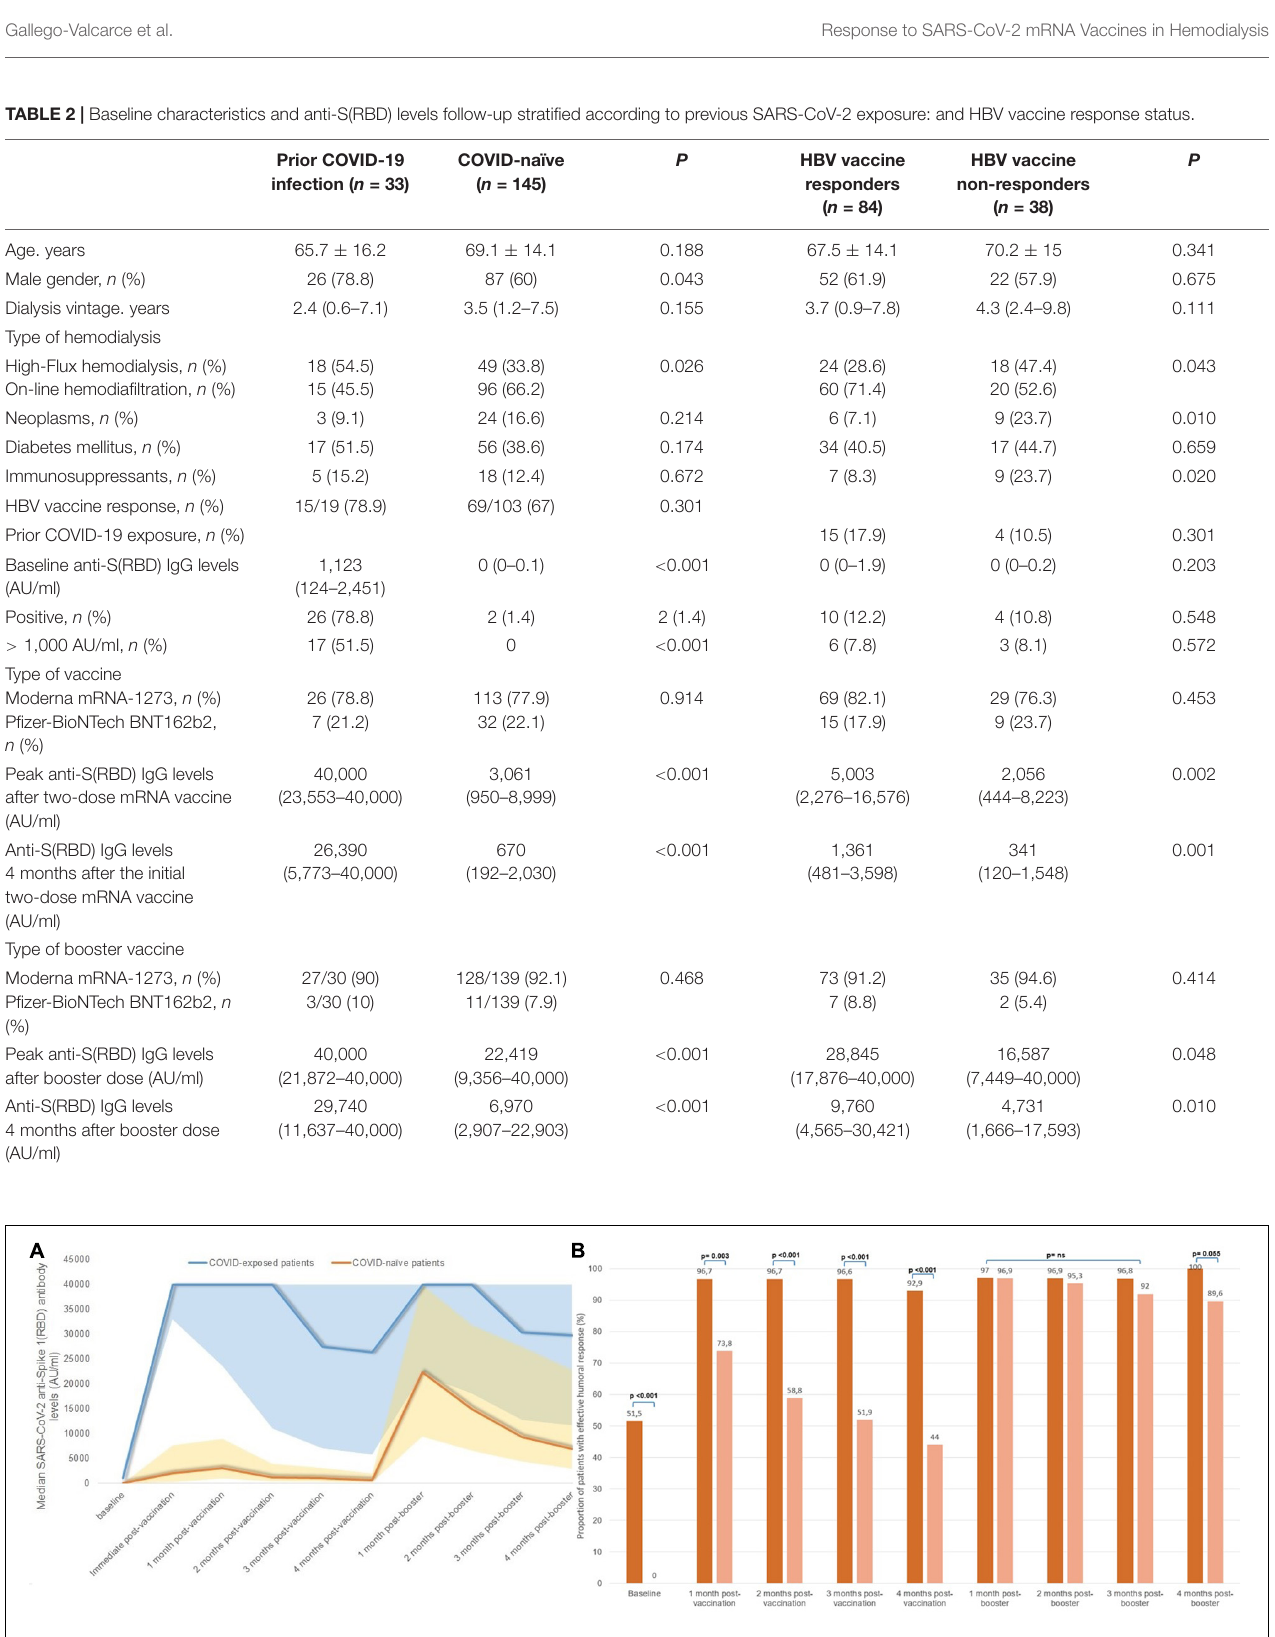
Frontiers in Medicine |